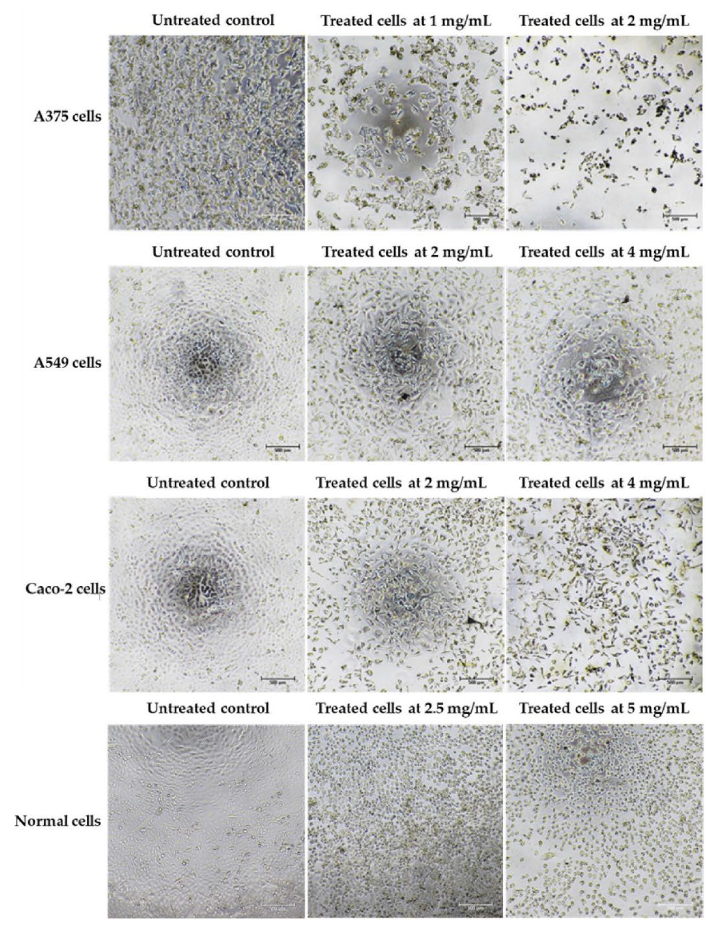
Figure 5. Morphology of skin cancer A375 cells, lung cancer A549 cells, colon cancer Caco-2 cells, and normal Vero cells after treatment with the ethanolic extract from cyanobacteria, Leptolyngbya sp. KC45, when compared with control (untreated) cells for 48 h.